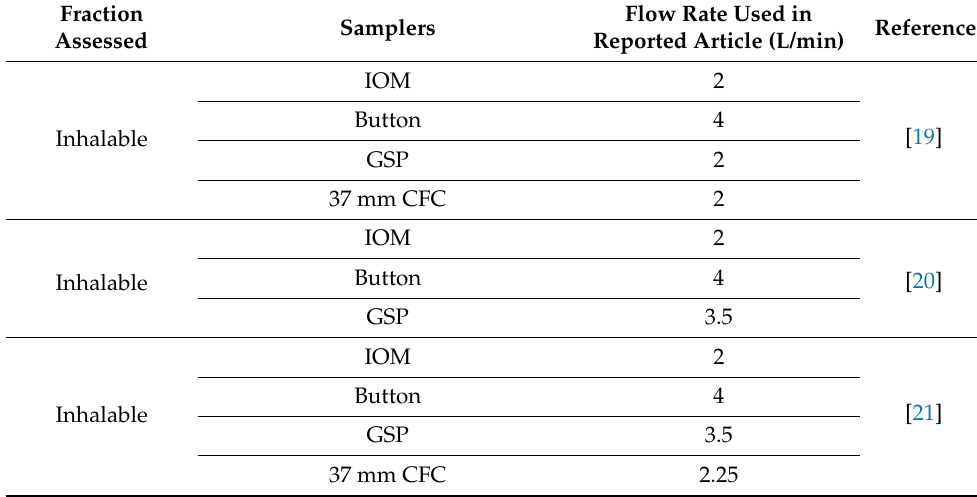
Table 1. Samplers assessed in sampler efficiency, performance and comparison articles in laboratory settings (note—names listed as stated in publication). The flow rates are as stated in the article, in a number of articles more than one flow rate was used for a sampler and these are reported as